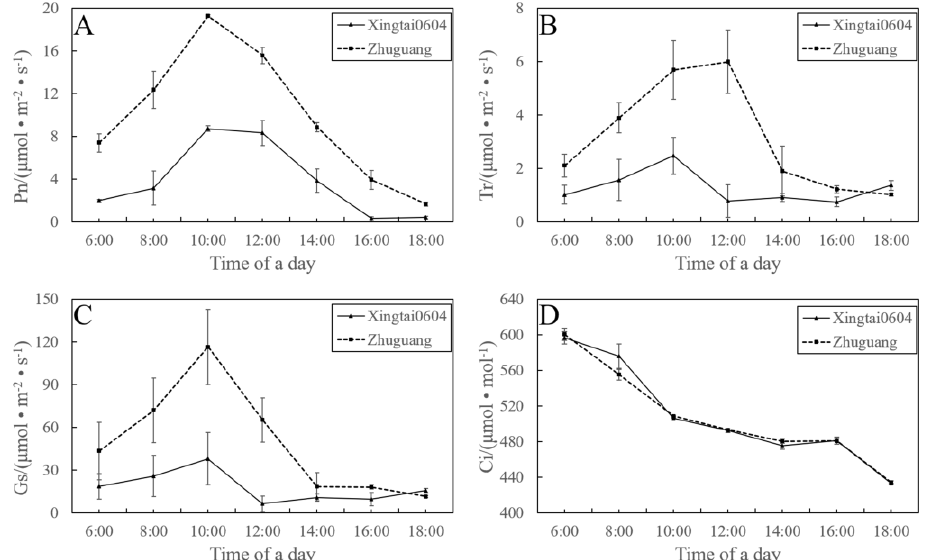
Figure 7. Diurnal photosynthetic parameter changes in ‘Xingtai 0604′ (2 x ) and ‘Zhuguang’ (4 x ). Pn, photosynthetic rate ( A ); Tr, transpiration rate ( B ); Gs, stomatal conductance ( C ); Ci, internal CO 2 concentration ( D ). Vertical bar at each point represents the standard deviation.